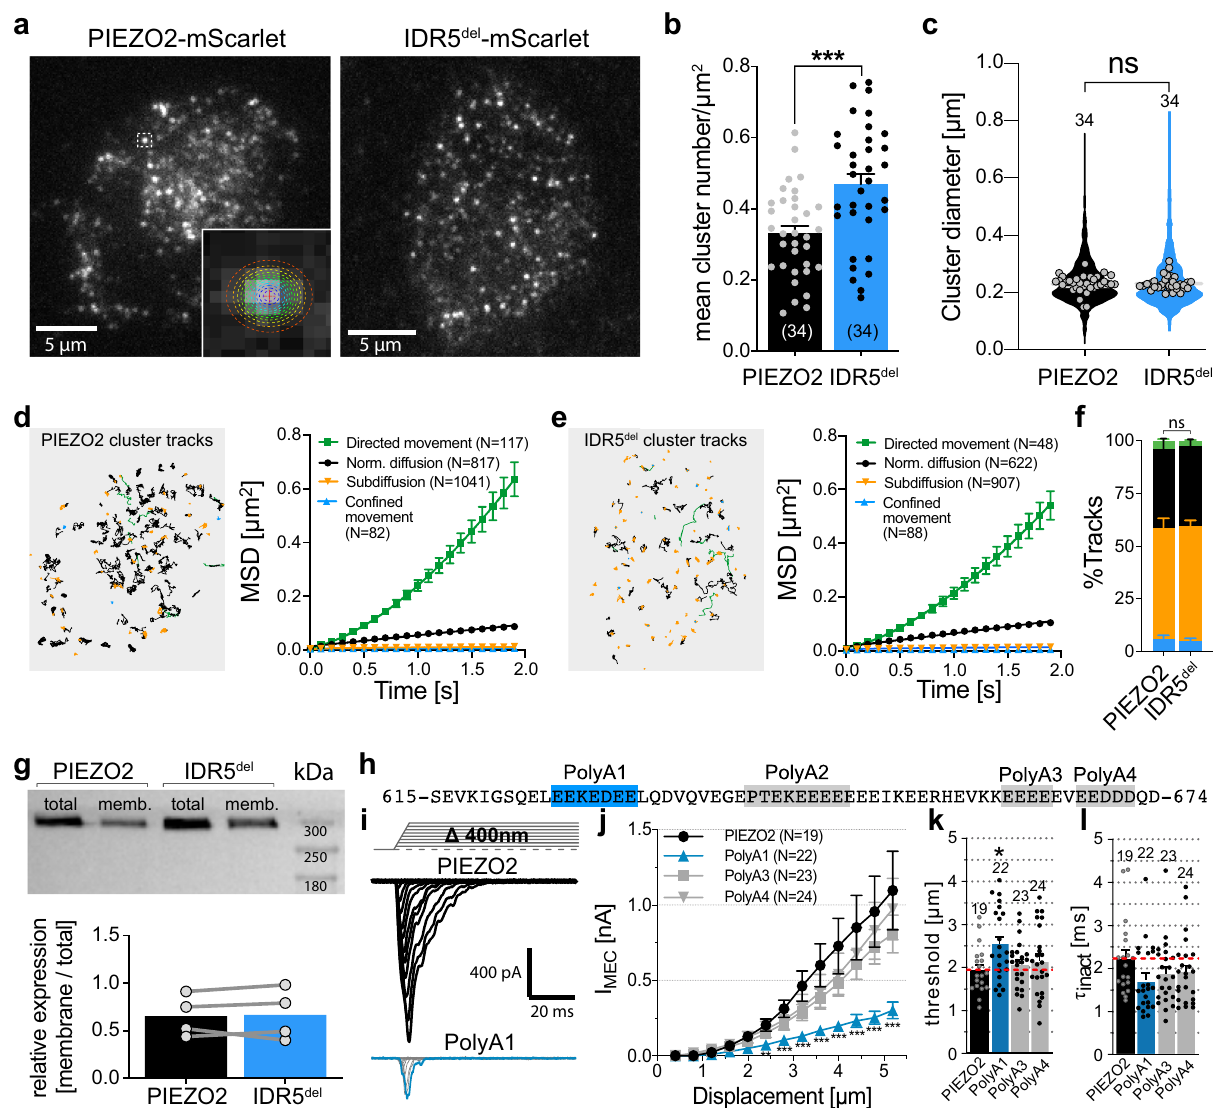
Fig. 4 IDR5 deletion does not affect PIEZO2 traf fi cking, clustering or lateral diffusion in the plasma membrane. a Example TIRF images of PIEZO2- mScarlet and IDR5 del -mScarlet clusters. Inset shows Gaussian fi t of a PIEZO2 cluster. b Mean cluster densities of 34 PIEZO2-mScarlet (black) and 34 IDR5 del -mScarlet (blue) expressing cells were compared with unpaired t -test (*** p = 0.0003). Error bars represent s.e.m. and means from individual cells are shown as circles. c Violin plot of individual cluster diameters (PIEZO2, N = 2153 and IDR5 del , N = 2765) and mean cluster diameters per cell (gray circles, N = 34). Mean cluster diameters were compared using Mann – Whitney test ( p = 0.3152). Tracks of the clusters shown in ( a ) (left) for PIEZO2 ( d ) and IDR5 del ( e ) and plots of the Mean-Squared-Displacement as a function of lag time (right) for the 4 track categories. Symbols represent means ± s.e.m. Tracks from 2057 PIEZO2 and 1665 IDR5 del clusters from 13 cells each were analyzed (N-Numbers for track-categories are provided in graph). f Proportions of clusters assigned to the different track categories from 13 PIEZO2 and 13 IDR5 del -expressing cells are shown in a stacked bar graph (mean ± s.e.m.) and compared using Mann – Whitney test, (Directed p = 0.2555, Norm. Diffusion p = 0.9197, Subdiffusion p = 0.6597, Con fi ned p = 0.99; color-code same as in d ). g Western blot of whole-cell lysate (total) and biotinylated membrane fraction (memb.) of PIEZO2 and IDR5 del -transfected N2a- P1KO cells and bar graph of densitometric quanti fi cation (means with individual values from 4 independent assays. Mann – Whitney test, ( p = 0.7553). h PIEZO2-IDR5 sequence with positions of PolyA substitutions highlighted. i Example traces of poking-evoked PIEZO2 and PolyA1-mediated whole-cell currents. j Displacement-responses curves of current amplitudes of PIEZO2 and PolyA mutants. For each stimulus, current amplitudes were compared with Kruskal – Wallis test and Dunn ’ s post-test. P -Values for PIEZO2 vs PolyA1 (from left to right): **0.004, ***0.0007, ***0.0003, ***0.0002, ***0.0001, ***0.0002, ***0.0002, ***0.0002). k , l comparisons of the mean ± s.e.m. mechanical activation thresholds and inactivation time constants of PIEZO2 and PolyA1 mutants with One-Way ANOVA, (F(3, 84) = 2.863; Dunnett ’ s post-test PIEZO2 vs PolyA1, * p = 0.0211) and Kruskal – Wallis test ( p = 0.1997), respectively. N-numbers per group are provided above each bar. Source data are provided as a Source Data fi le.